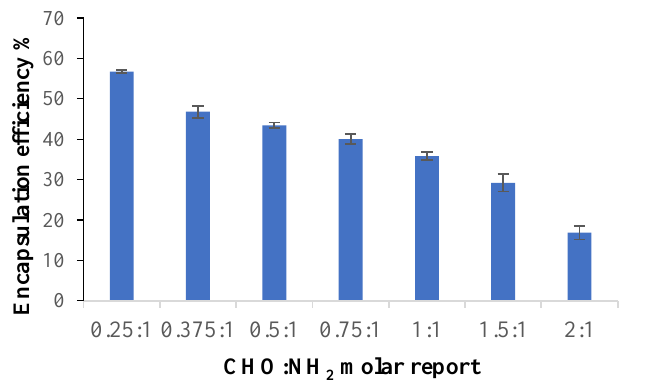
Figure 12. Curcumin encapsulation efficiency in CS/CMCOx films obtained at different CHO: NH 2 molar ratios.